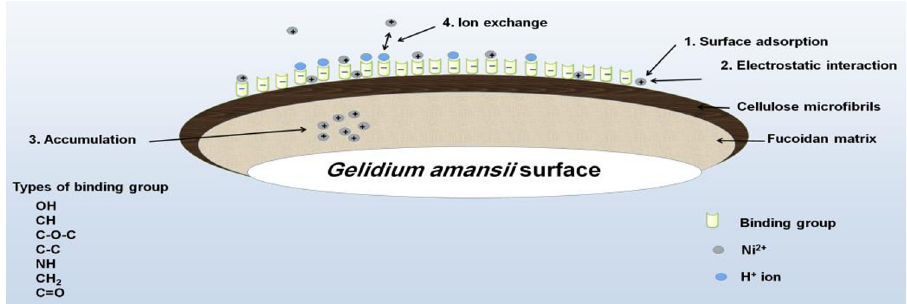
Figure 7: Mechanism of bio - removal nickel ions by G. amansii